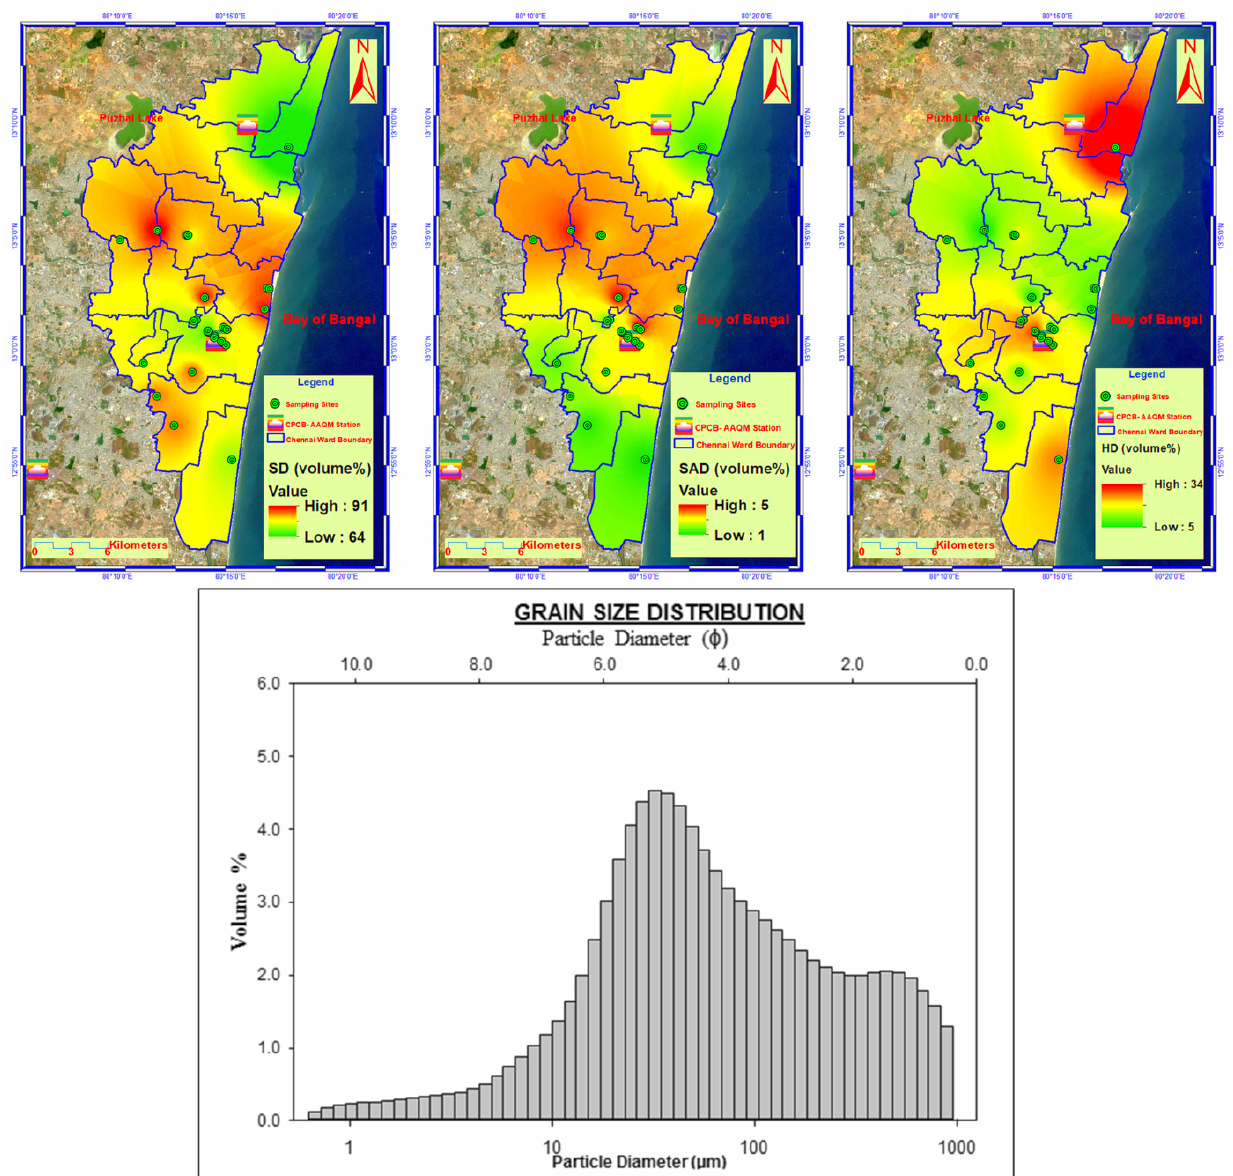
Figure 4. The particle size of particulate samples classified based on size (SAD-0.001 μ m to 1 μ m; SD-1 μ m to 100 μ m; HD-100 μ m to 1000 μ m) in all sampling sites of the study area. The size of the suspended atmospheric particulate is less than 1 μ m, which is the finest particle that causes harmful effects on human health since they are easily inhaled, ingested, or dermally contacted by humans [15]. These suspended atmospheric particu- late particles were highest (4.7%) in roadside samples, followed by commercial areas (4.2%), which indicates the increase in air pollution in the roadside areas given in the Sup- plementary Materials (Figure S1). Very fine particles may pass through the skin and enter the body like soluble particles that dissolve and pass through the. These particulate sam- ples can cause adverse effects on the elderly, children, and people with chronic lung dis- ease and influenza skin [36]. The volume of settled particulate samples with a size range of 1 μ m to 100 μ m is 60% in all the locations, as shown in the Supplementary Materials (Figure S2). These settled particulate samples can cause various health issues like eye irri- tation, respiratory problems (asthma), non-malignant respiratory diseases, lung cancer in non-smokers, bronchitis, oxygen deficiency in blood, and decreased lung function [2]. The